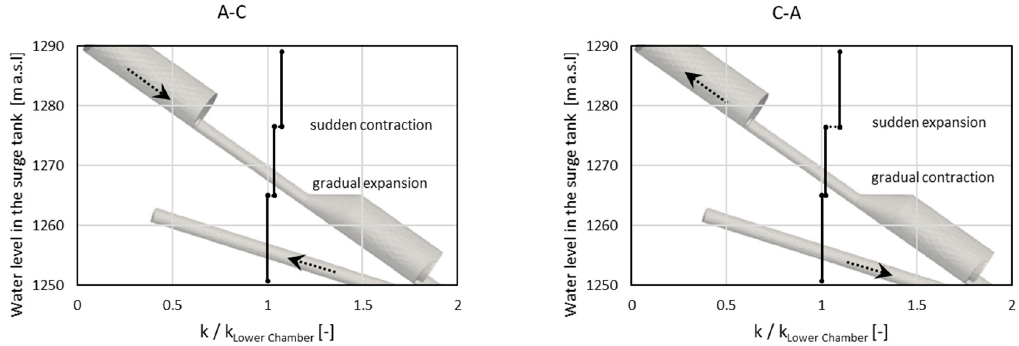
Figure 8. Variation of relative value of the head loss coefficient k AC (surge tank outflow) and k CA (surge tank inflow) with the water level in the surge tank.